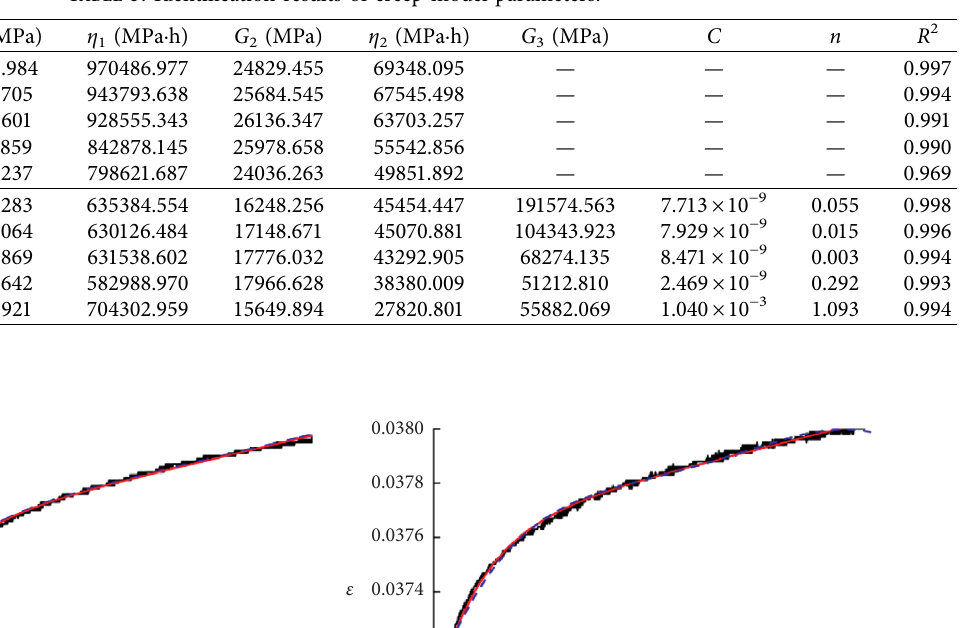
Table 3: Identification results of creep model